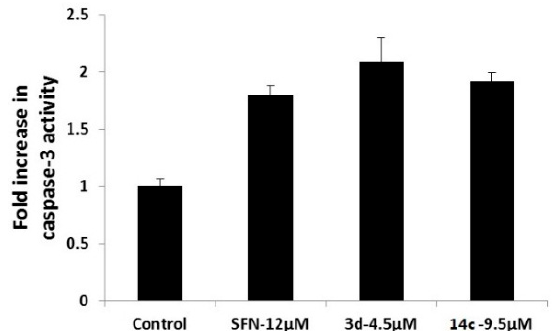
Figure 1. SFN, 3d and 14c enhanced caspase-3 activity in SUM-159 cells.